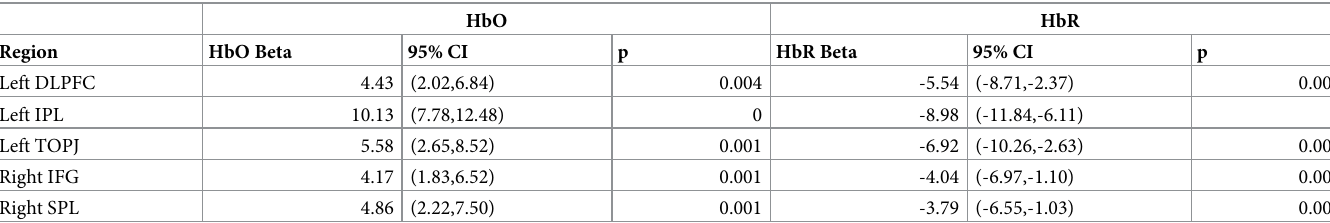
Table 1. Beta contrast of activation for funny > neutral for regions surviving FDR correction of p < 0.05 for both HbO and HbR. HbO HbR Region HbO